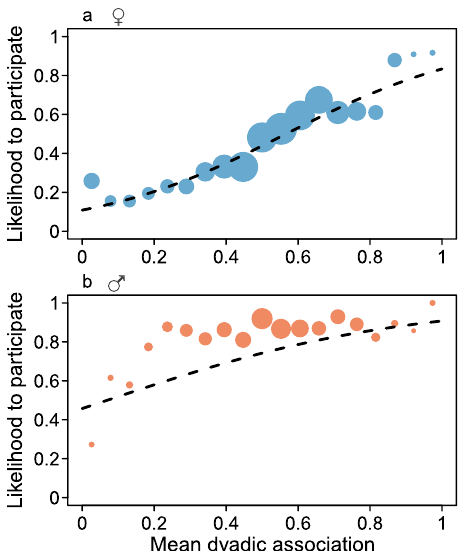
Fig. 3 Does spatial proximity in fl uence participation? The effect of average dyadic association with all adult participants on the likelihood of a females (blue, 75 individuals) and b males (orange, 36 individuals) to participate in intergroup encounters. Larger point denotes larger number of observations and dashed lines represent the model lines. Source data are provided as a Source Data fi